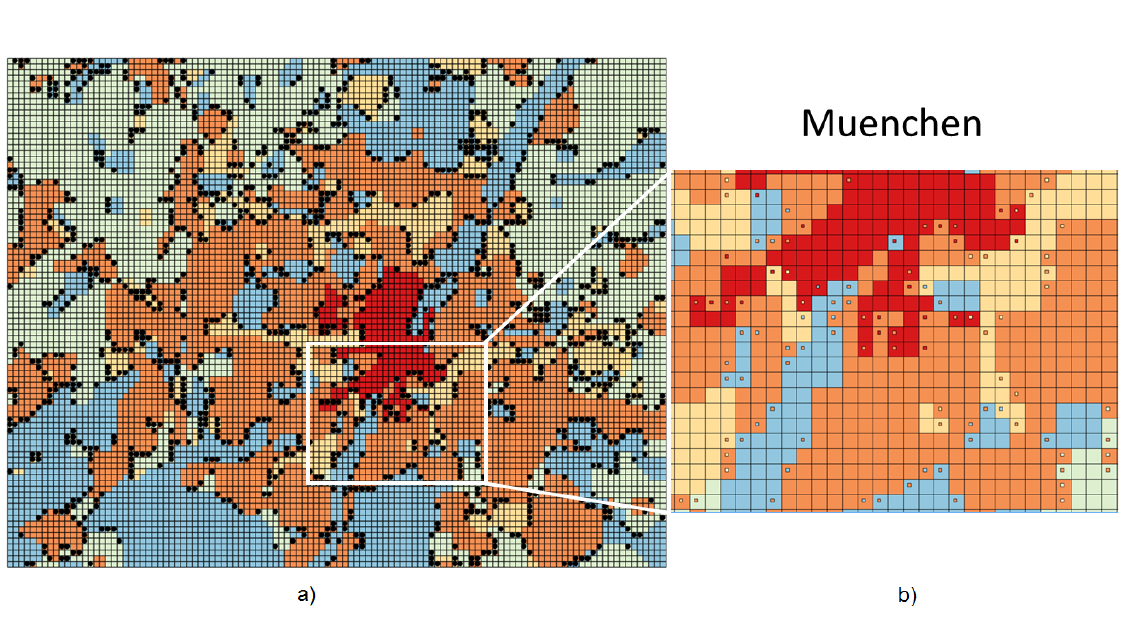
Figure 2. Spatial distribution of misclassified cells in München. “Dense residential” = red; “Sparse residential” = orange; “Industrial” = yellow; “Agricultural” = green; and “Nature” = blue. ( a ) Misclassified cells (black dots) on the entire München area; ( b ) Error types in a zoomed